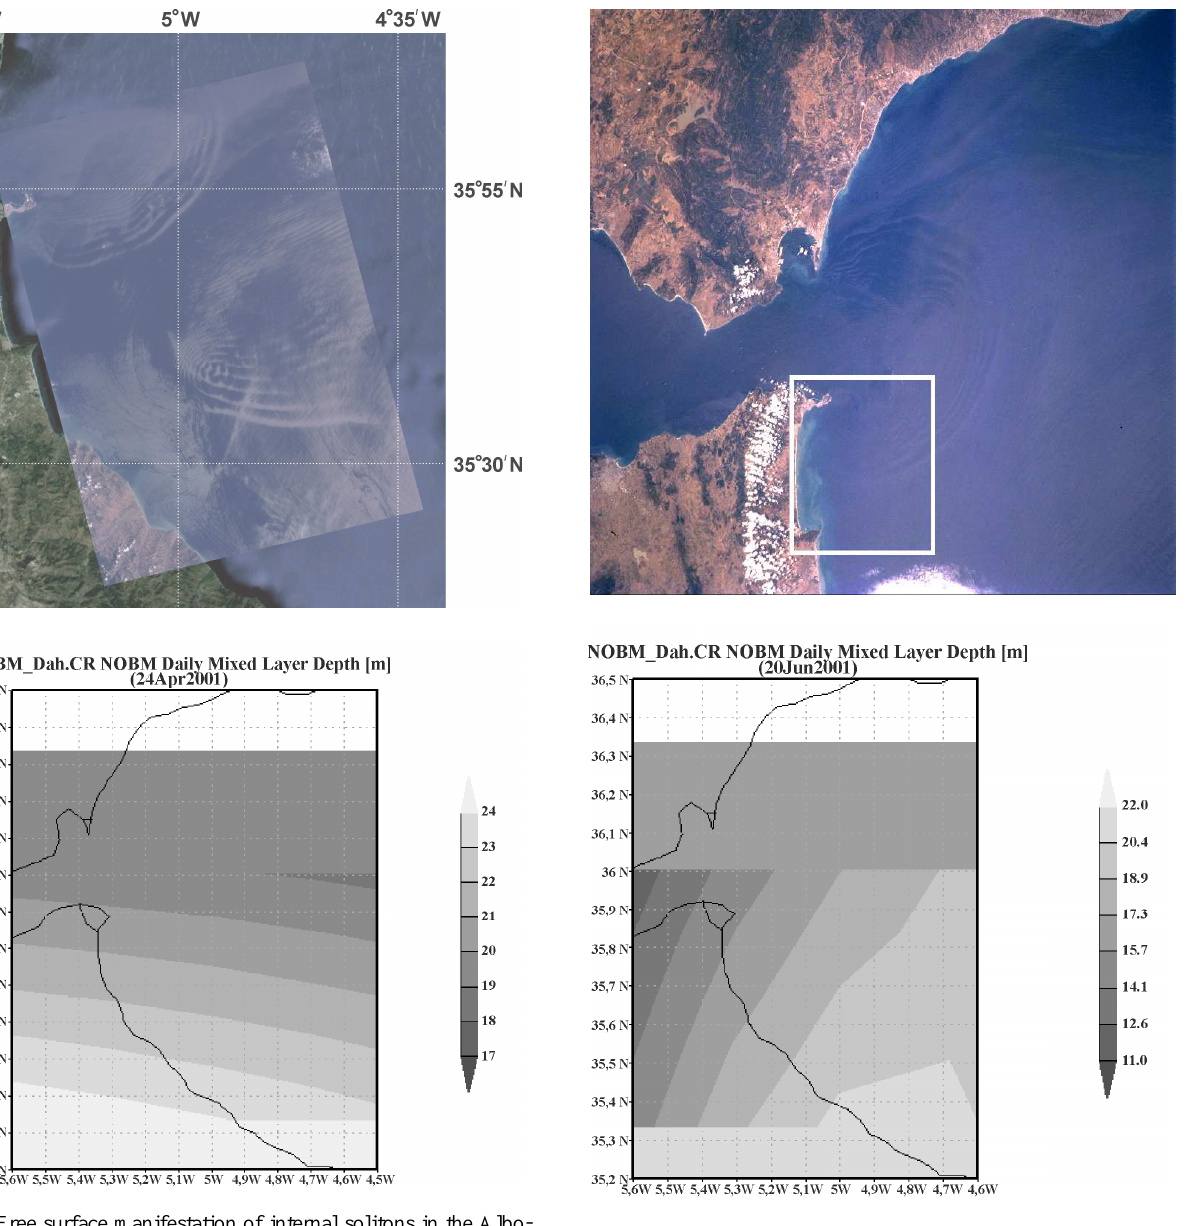
Fig. 9. Free surface manifestation of internal solitons in the Albo- ran Sea NASA photo ISS002-724-12 (20 June 2001). Colour bright- ness was modified to achieve appropriate view of details. The mixed Figure 9. Free surface manifestation of internal solitons in the Alboran Sea NASA photo 2 layer depth averaged over 20 June 2001 is displayed ISS002-724-12 (20 June 2001). Color brightness was modified to achieve appropriate view of 3 details. The mixed layer depth averaged over 20 June 2001 is displayed below. 4